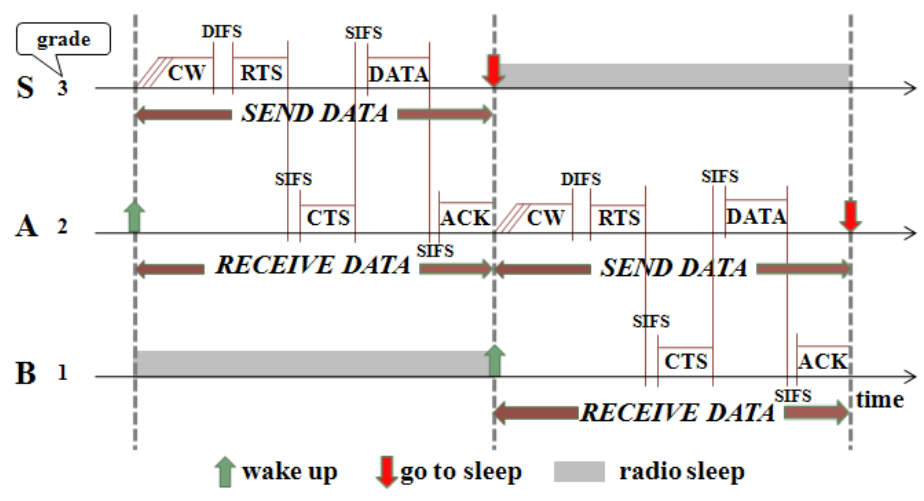
Figure 5. Basic P-MAC without routing function.